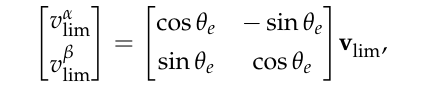
where V dc is the dc link voltage.